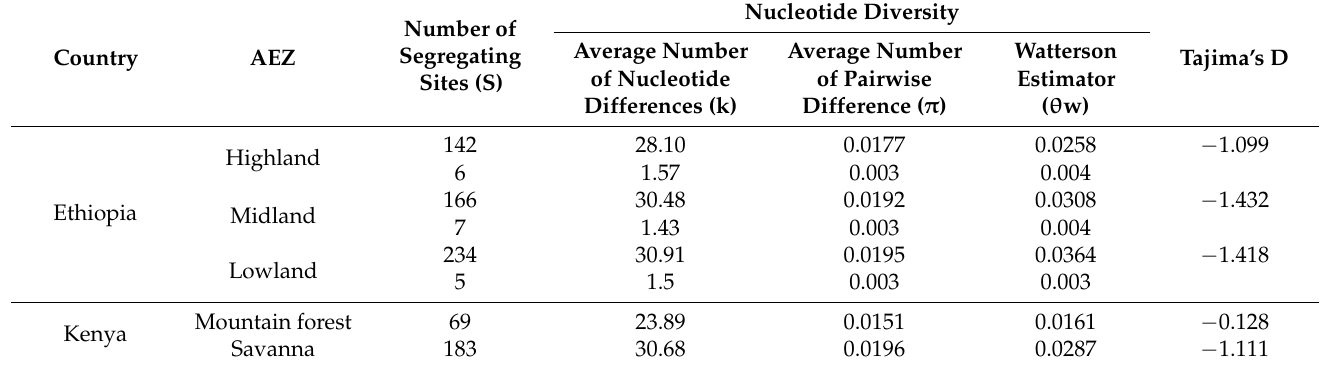
Table 3. Population genetic parameters for highland, midland and lowland agro-ecological zones (AEZs) pooled from four local areas of Ethiopia and Kenyan reference samples from two local areas (Mau and Mount Kenya). For Ethiopian samples, data are given for r7- frag (first rows in each group) and COI-COII (second rows in each group) and for Kenyan samples, r7- frag